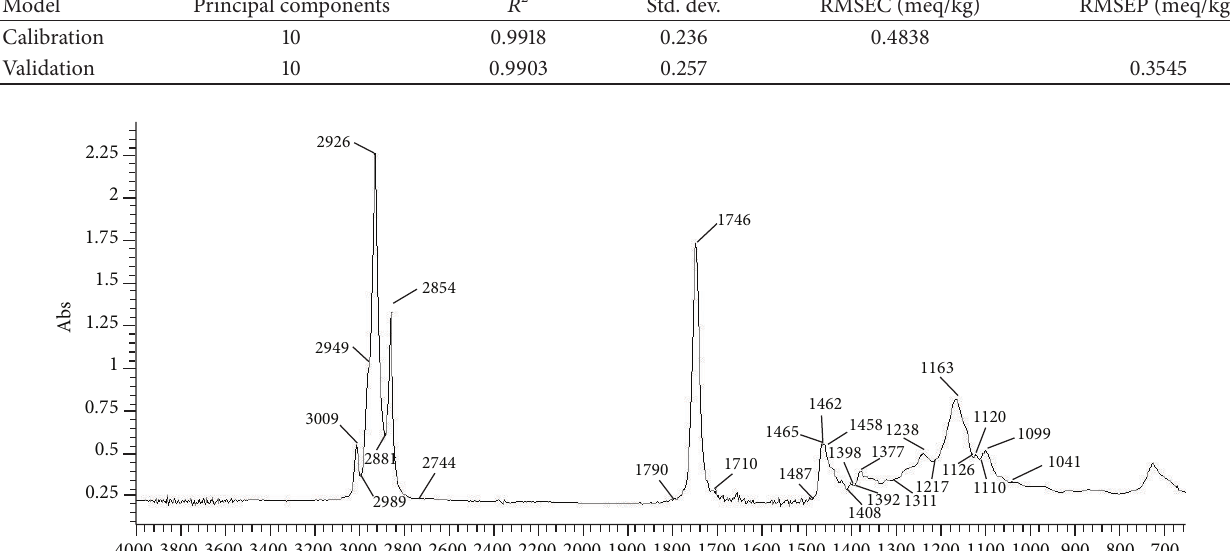
Figure 1: IR spectra of virgin walnut oil (VWO) sample before oxidation.